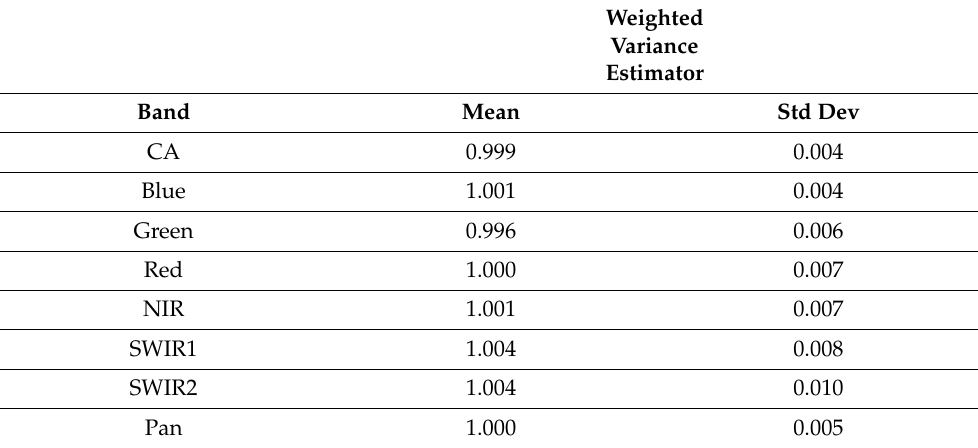
Weighted Variance Estimator